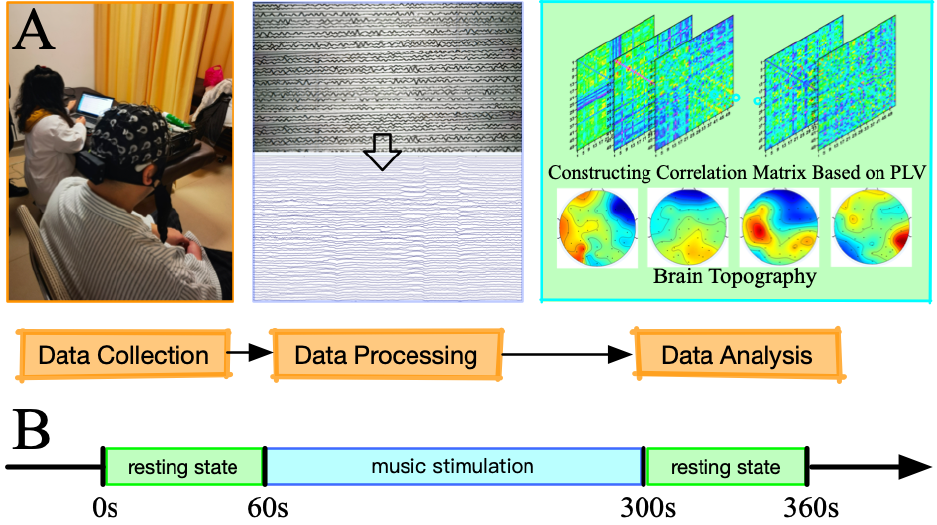
Figure 1. EEG acquisition process. ( A ) Experimental flowchart; ( B ) time distribution of musical stim- ulation.